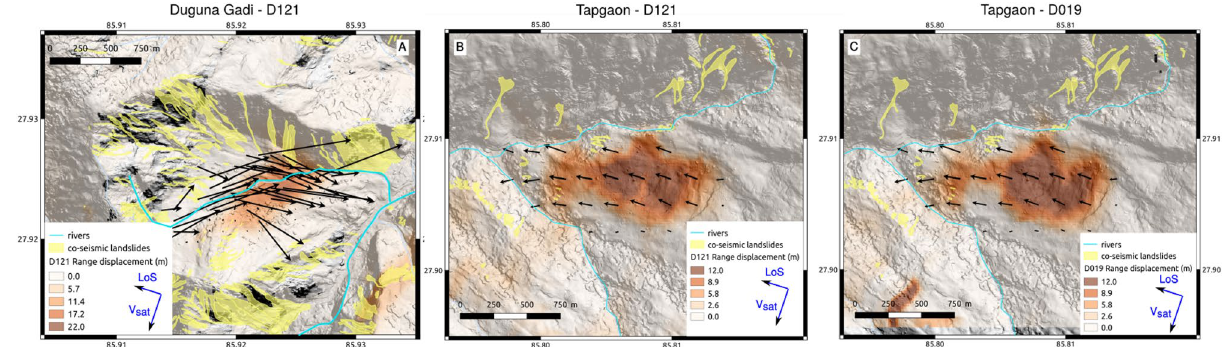
Figure 4. SAR Range displacements from Sentinel-1 images on the Duguna Gadi ( A ) and Tapgaon ( B , C ) landslides overlayed over the DEM produced with the December 2015 Pléiades images (see section Methods). The displacements are calculated over the entire 2015 year using the methodology presented in the Methods section, on either the D121 Sentinel-1 track ( A , B ) or the D019 Sentinel-1 track ( C ). Arrows correspond to the displacement field of the landslides calculated with Pléiades images. The white squares are the locations at which the time-series of displacements are extracted in Fig. 5. QGIS 23 was used to create this